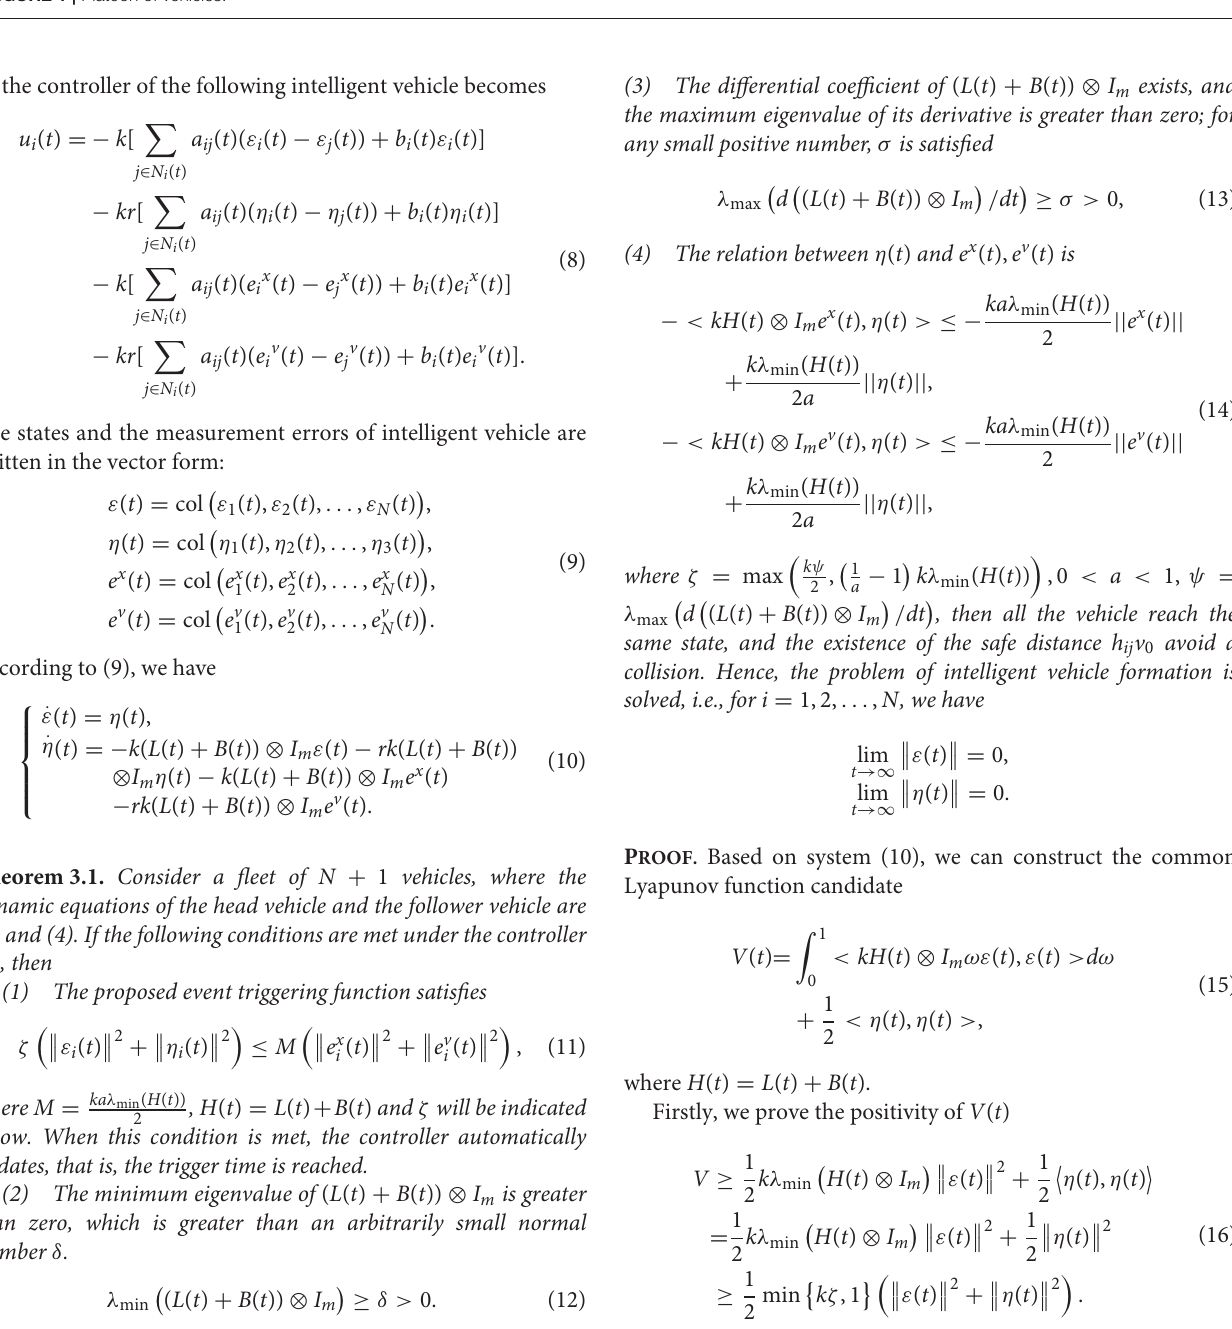
FIGURE 1 | Platoon of